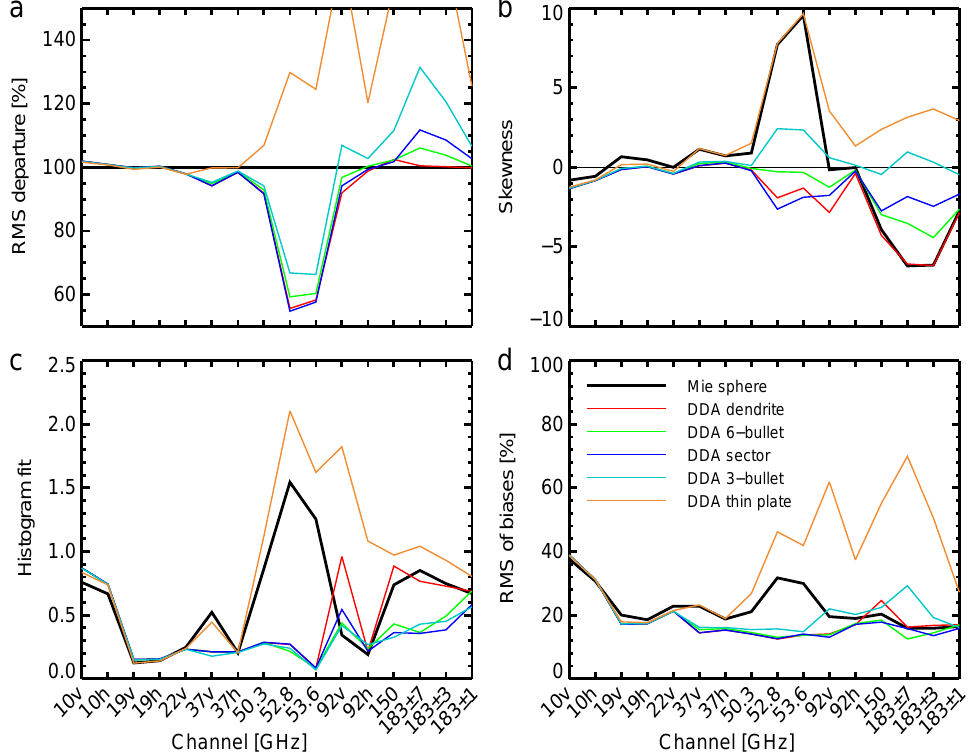
Figure 7. Measures of fit between model and observations over ocean surfaces: (a) The rms of FG departures, normalised by the Mie sphere results; (b) skewness of FG departures; (c) brightness temperature histogram fit; (d) rms of mapped biases. Lower numbers indicate better agreement between model and observations; in the case of the skewness, large negative or positive numbers are